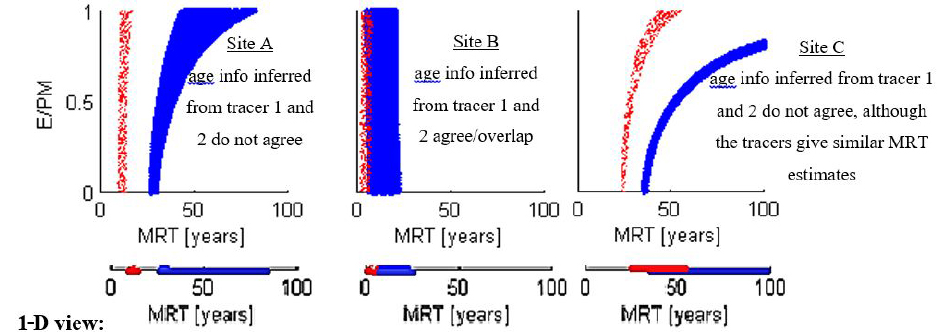
Figure 4. Example of behavioural lumped parameter model (LPM) parameter clouds inferred from two different tracers (tracer 1 in red and tracer 2 in blue). For site B (MIDDLE) the inferred LPM parameter clouds overlap, indicating that the age interpretation inferred from each tracer agree. For site A and C (left and right) the inferred LPM parameter clouds do not overlap, indicating that the two tracers give different age interpretations. For site C the tracers give similar MRT estimates, giving the impression that the tracers’ age information agree when only looking at one dimension (bottom of each figure). To quantify difference or disagreement, the distance between the data clouds can be determined. (It might be useful to have one more example where the age information 1 and 2 overlap only at a certain E / PM ratio – this is a very realistic scenario using two tracers to constrain the E / PM